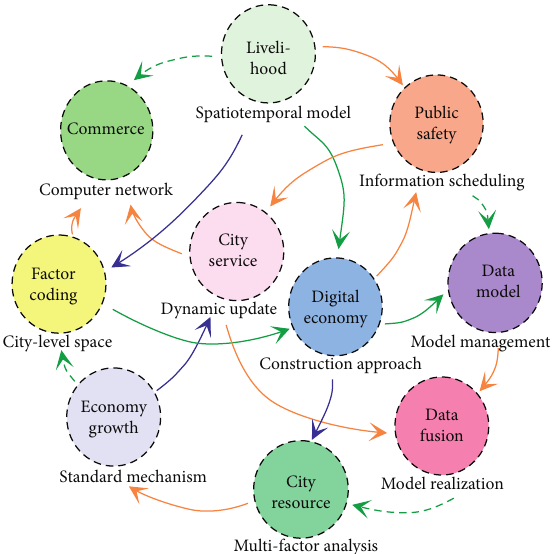
Figure 6: Realization of people-oriented social management model based on digital